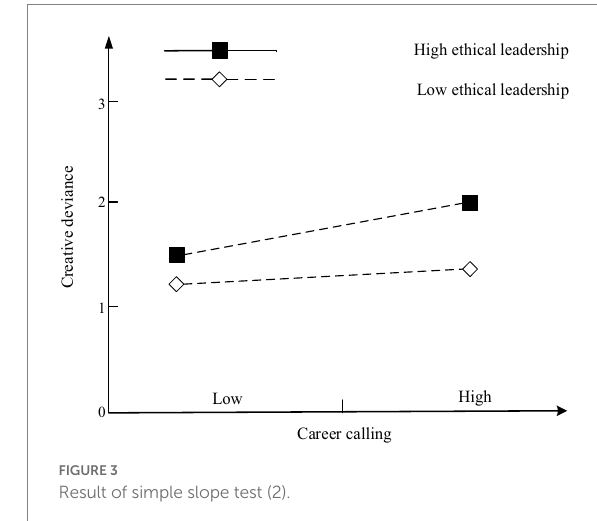
FIGURE 3 Result of simple slope test